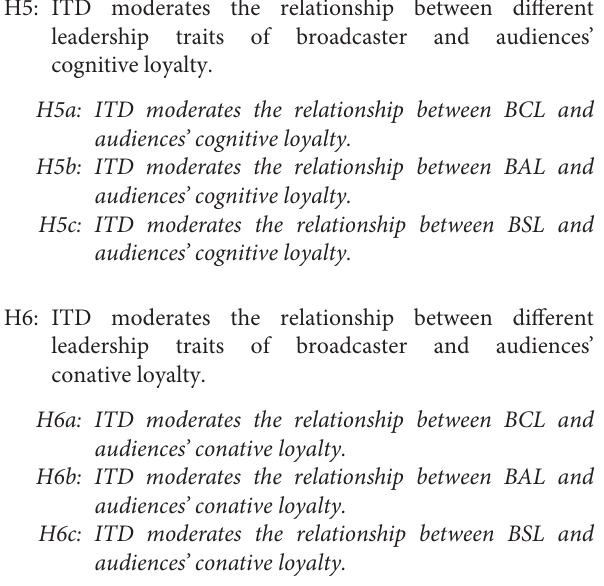
audiences’ conative